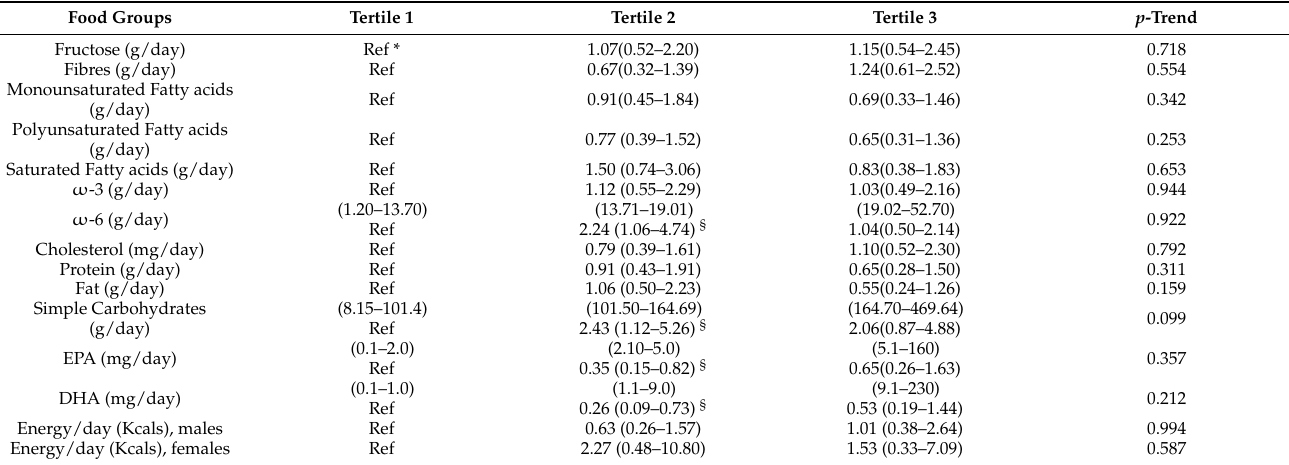
Table 5. Hepatic fibrosis across tertiles of food